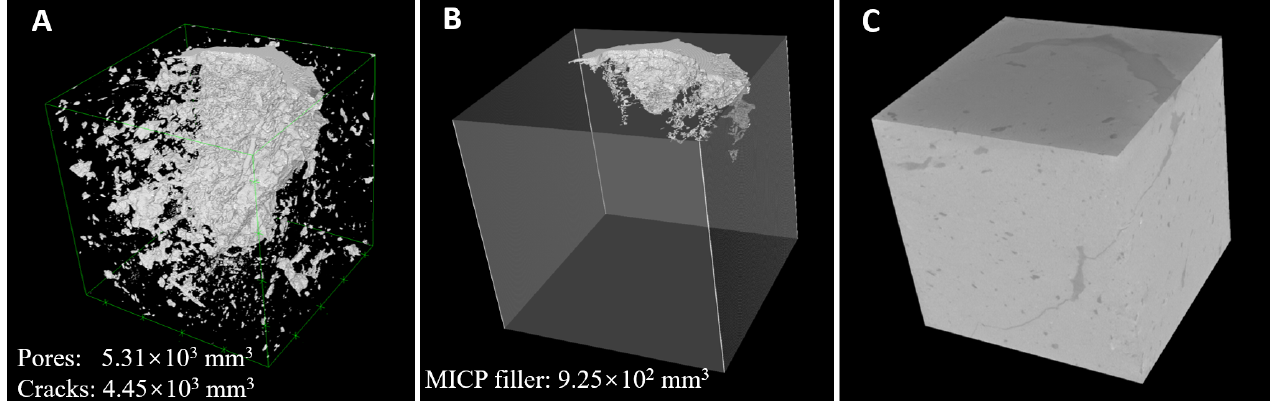
Figure 7. 3D visualization of the brick cubes with natural cracks after MICP treatment. ( A ) Distribution of pores; ( B ) MICP filler; ( C ) the external surfaces of the MICP treated brick cube.